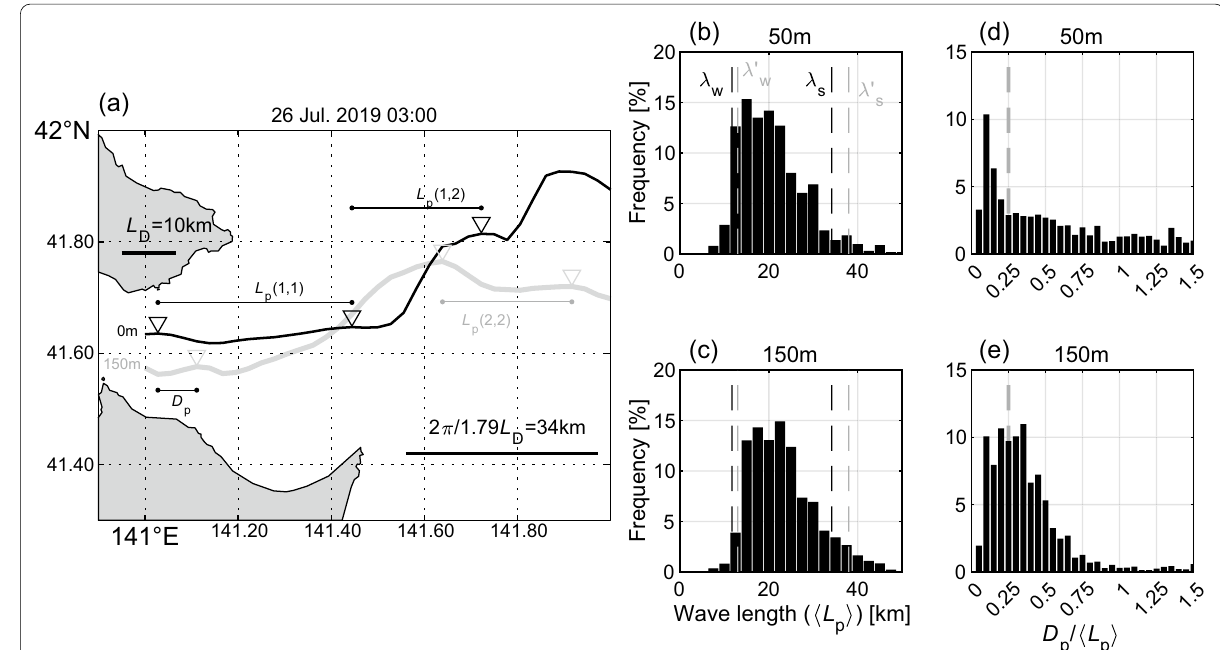
Fig. 10 a An example of the axis latitude distribution obtained from the JCOPE-T DA data. The black (gray) color is that at the surface (150 m). b and c : Frequency distribution of the representative zonal scale of adjacent peaks of the axis latitude obtained from the JCOPE-T DA ( L p ) at 50 m and 150 m, respectively. d and e : Frequency distribution of the ratio of the difference in the first axis latitude peaks (from west) between the surface and lower depths ( D p , 50 m and 150 m, respectively) to L p . The black (gray) vertical lines in b and c denote wavelengths with maximum growth rates in the two-layer model (Eady’s model). Subscripts w and s indicate winter and summer,